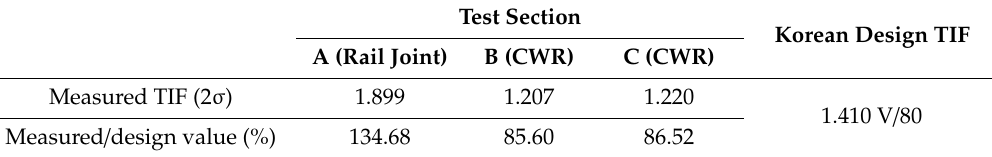
Table 3. Comparisons of track impact factor (TIF) between the design value and measured